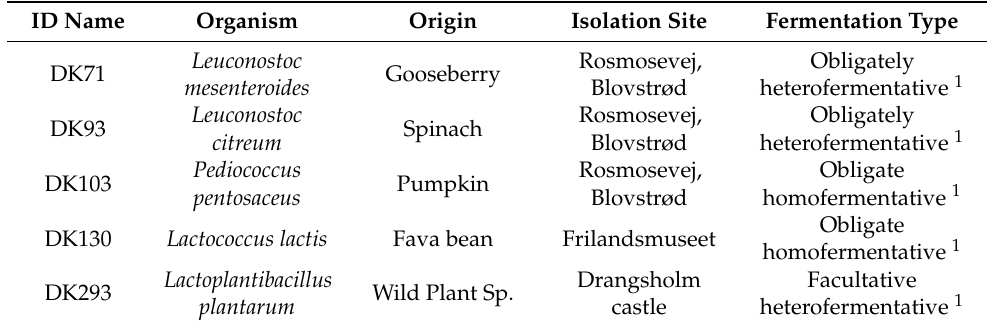
Table 2. Meta data for the five in-house strains. All strains were isolated from locations in